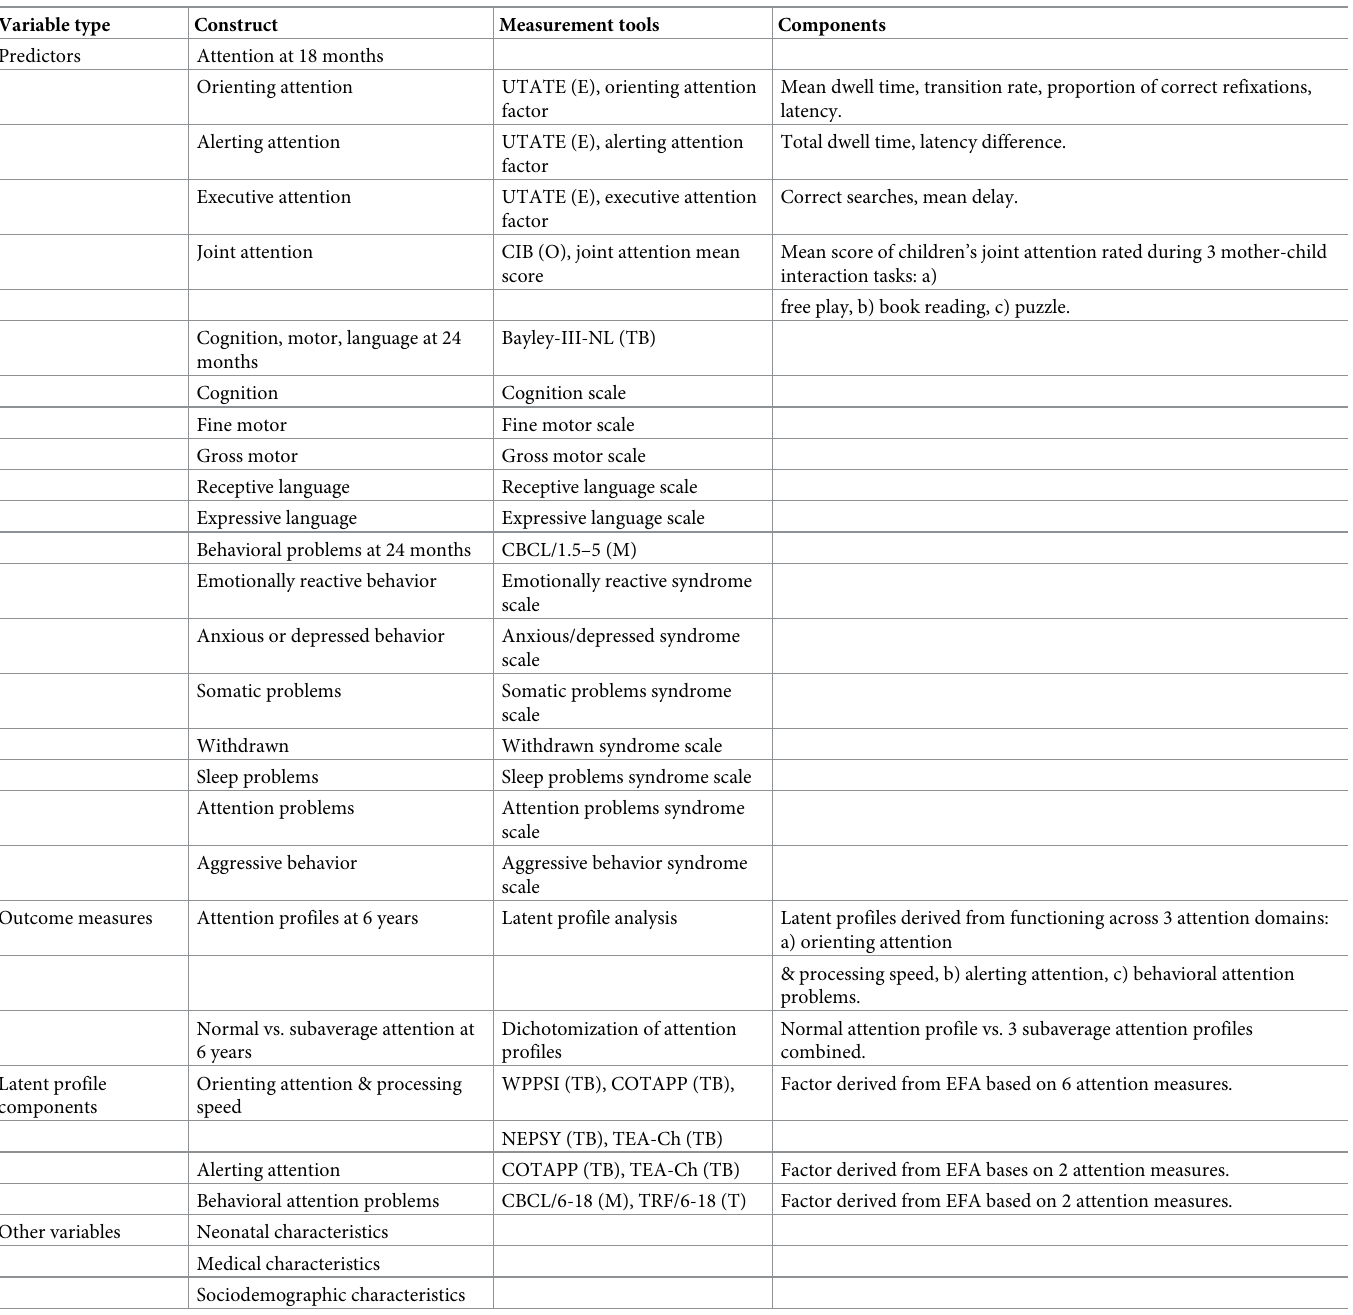
Table 1. Overview of